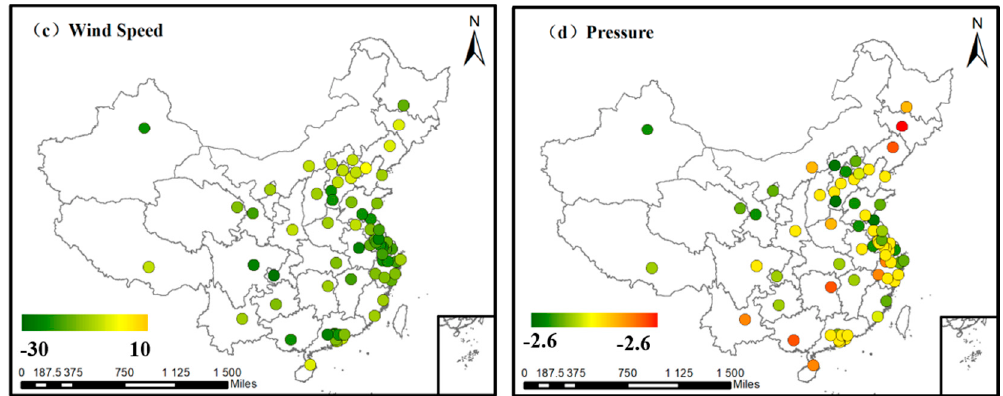
Figure 11. The distribution of the regression coefficient of four factors at year scale.